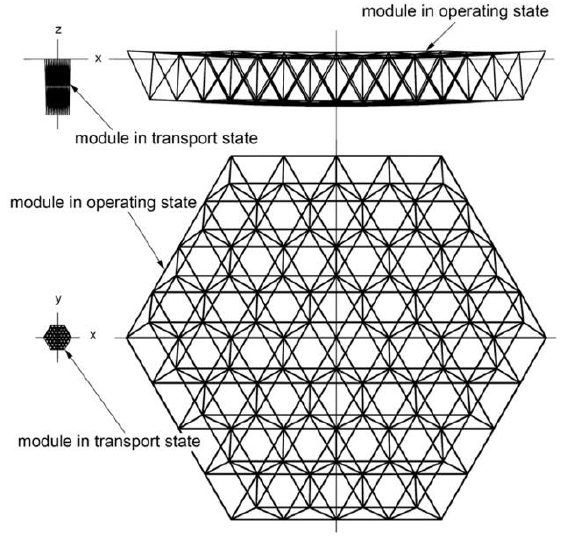
Fig. 7. The truss module in folded transport state and unfolded operating state.